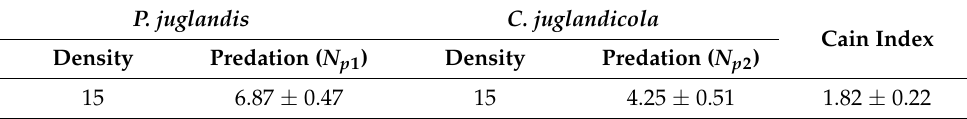
Table 2. Prey choice of predatory O. sauteri bug against two walnut aphid